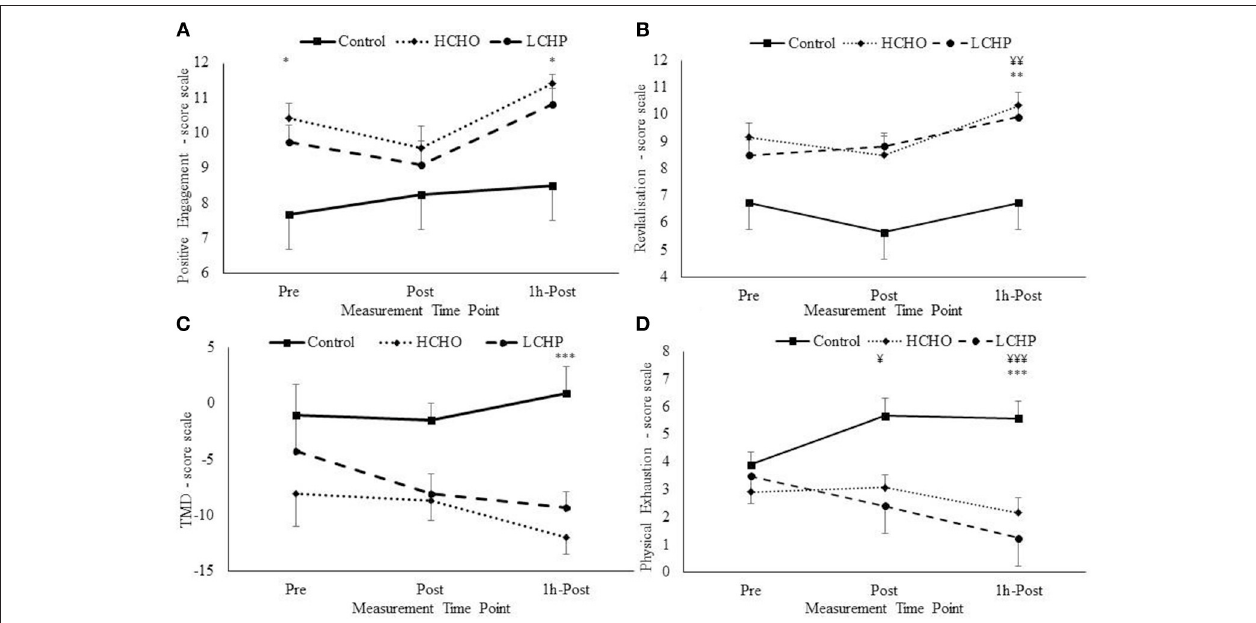
FIGURE 5 | Positive engagement (A) , Revitalisation (B) , Total Mood Disturbances (TMD) (C) , and Physical exhaustion (D) changes pre, post and 1 h-post-exercise from EIFI questionnaire for HCHO, LCHP, and control. * p < 0.05, ** p < 0.01, and *** p < 0.001 between HCHO and control condition, and U p < 0.05, UU p < 0.01, UUU p < 0.001 between LCHO and control condition. Values are mean ± SEM, n =